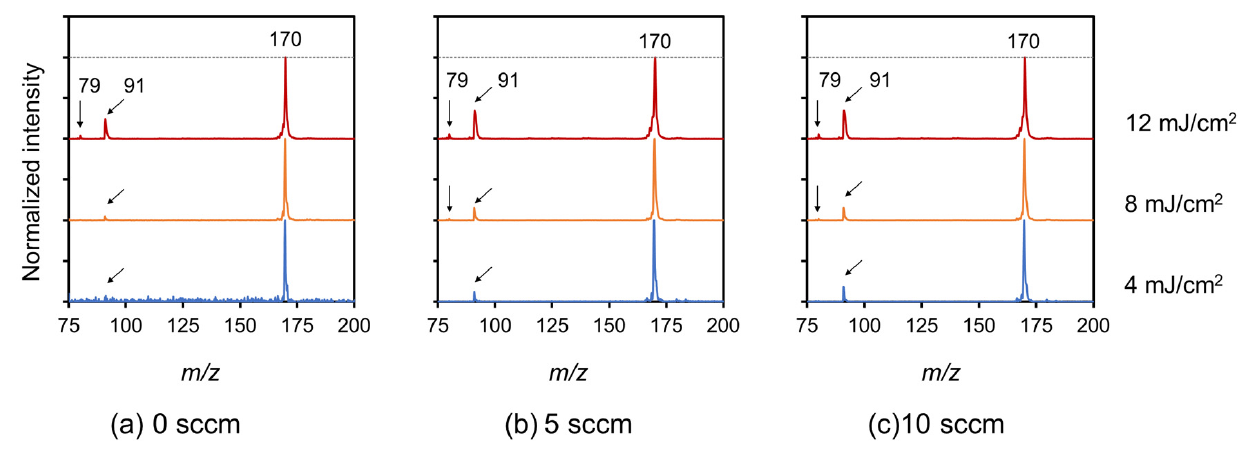
Figure 9. SALDI mass spectra of N-BP-Cl on high-quality CNWs ionization-assisting substrates measured at various laser fluences of 4, 8, and 12 mJ/cm 2 . ( a ) Normal CNWs, ( b ) 5-sccm-O 2 –, and ( c )10-sccm-O 2 – high-quality CNWs. (a) Normal CNWs are cited from the publication for compari- son